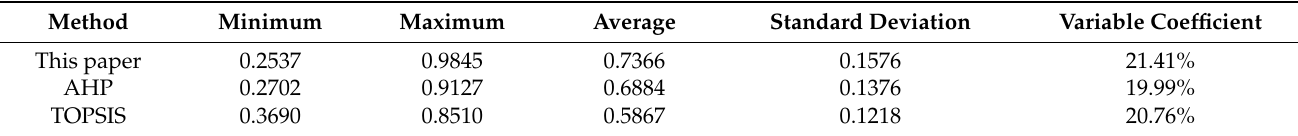
Table 7. Statistics of evaluation results of three methods under target layer